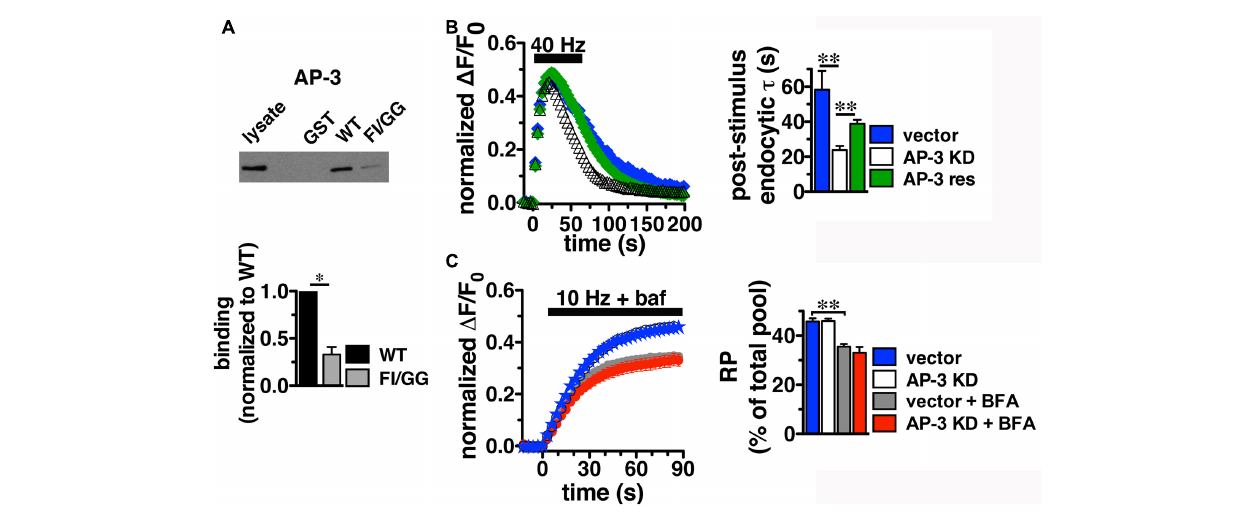
FIGURE 8 | Adaptor protein AP-3 interacts with VGLUT2 and regulates the rate of VGLUT2-pH endocytosis. (A) A GST fusion of the WT VGLUT2-pH C-terminus pulls down AP-3 from rat brain lysate. Mutation of the F 518 I 519 residues of the dileucine-like motif disrupts the interaction. Bound proteins were detected by immunoblotting with antibody against AP-3 (anti- β -NAP). The top panel shows a representative immunoblot, the bottom shows the quantification of WT and mutant band intensities from at least three independent experiments, ∗ p < 0.05. (B) AP-3 KD accelerates the recycling kinetics of VGLUT2-pH. Left panel: The time course of fluorescence changes in boutons response to 40 Hz stimulation in neurons transfected with VGLUT2-pH and infected with viral particles expressing either vector control (blue) or AP-3 δ 1 shRNA (open symbols), or co-expressing siRNA resistant δ 1 (green). Depletion of AP-3 shifts the time course to the left, the fluorescence peaks earlier with AP-3 KD relative to vector control (vector, 23.50 ± 1.43 s, n = 5 vs. AP-3 KD, 20.14 ± 0.55 s, n = 7, ∗ p < 0.05). AP-3 KD does not alter the peak fluorescence level during stimulation, as a fraction of the total pool, but it increases the extent of fluorescence decay during stimulation (vector, 27.45 ± 3.46% from peak vs. KD, 54.14 ± 1.71%, ∗∗ p < 0.01). Right panel: AP-3 KD speeds the endocytic rate after stimulation (vector, τ = 55.50 ± 8.08 s vs. KD, τ = 20.40 ± 1.71 s, ∗∗ p < 0.01). Expression of an siRNA resistant δ 1 rescues the knockdown phenotype (green, τ = 42.14 ± 1.71 s, n = 8). Data in (B,C) are means ± SEM of (cid:49) F/F acquired every 3 s, normalized to total fluorescence. Data in (B) are from at least 52 boutons per coverslip from 5 to 8 coverslips from at least two independent cultures. (C) Depletion of AP-3 does not affect the proportion of VGLUT2-pH in the RP (vector, blue: 45.75 ± 1.34%; AP-3 KD, white: 45.95 ± 1.02%, n = 19). Treatment with BFA reduces the proportion of VGLUT2-pH in the RP irrespective of whether neurons were infected with vector control or AP-3 δ 1 shRNA (vector + BFA, gray: 35.56 ± 1.10%, n = 15) and knockdown conditions (AP-3 KD + BFA, red: 33.07 ± 2.35%, n = 10), ∗∗ p < 0.01. The rate of exocytosis in response to 10 Hz 90 s stimulation is not significantly altered by AP-3 knockdown, or inhibition by BFA [ (cid:49) F/F 0 (au/s): vector 0.0275 ± 0.0007; AP-3 KD 0.0257 ± 0.0005; vector + BFA 0.0296 ± 0.0009; AP-3 KD + BFA 0.0276 ± 0.0010]. Data in (C) are from at least 24 boutons per coverslip from 10 to 22 coverslips from at 4–6 independent